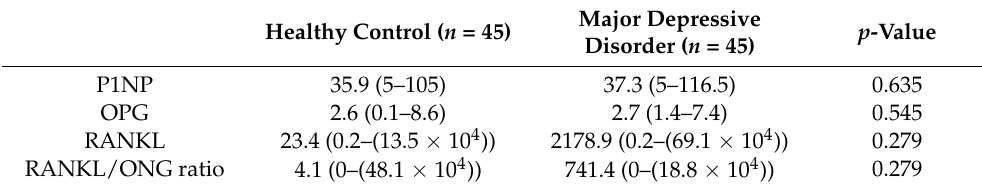
Table 3. Comparison of the median bone formation and metabolism markers between patients with MDD receiving SSRI treatment and healthy